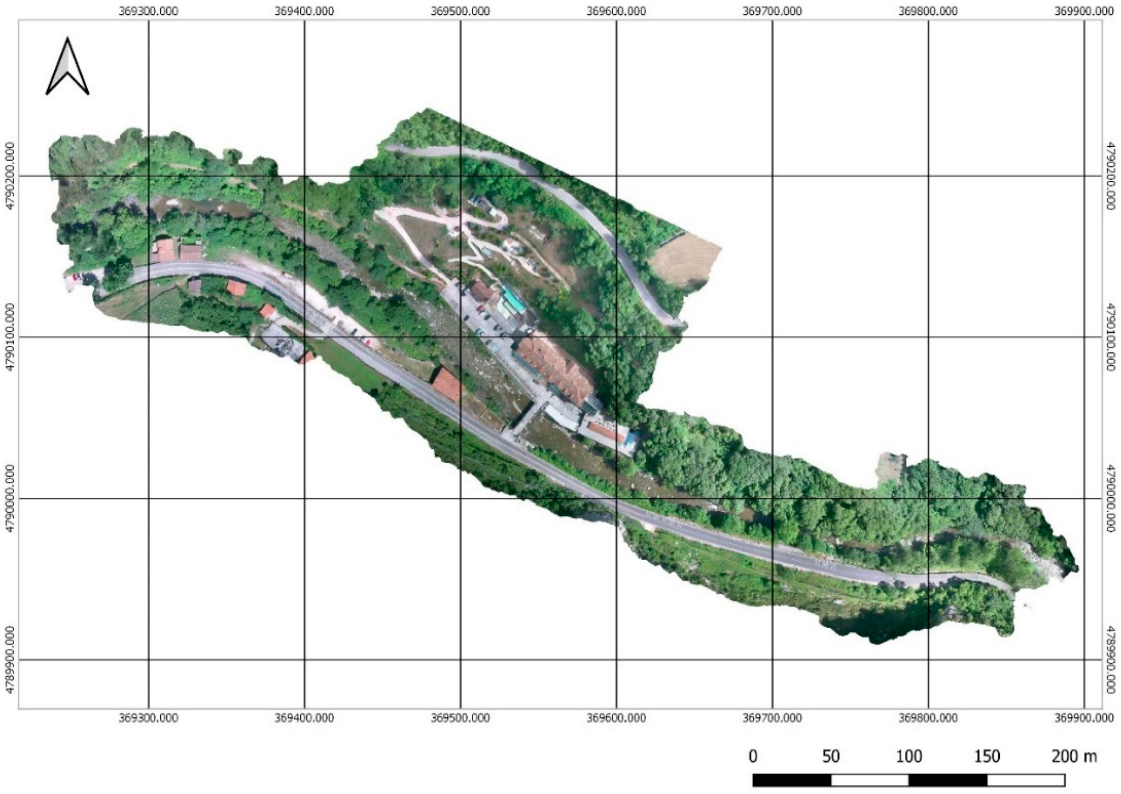
Figure 6. RGB Orthomosaic with a GSD of 4.27 cm/px.